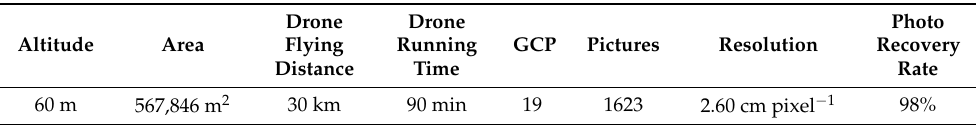
Table 1. Information on the drone photography taken in the Yubu Island tidal flat in the western coastal area of South